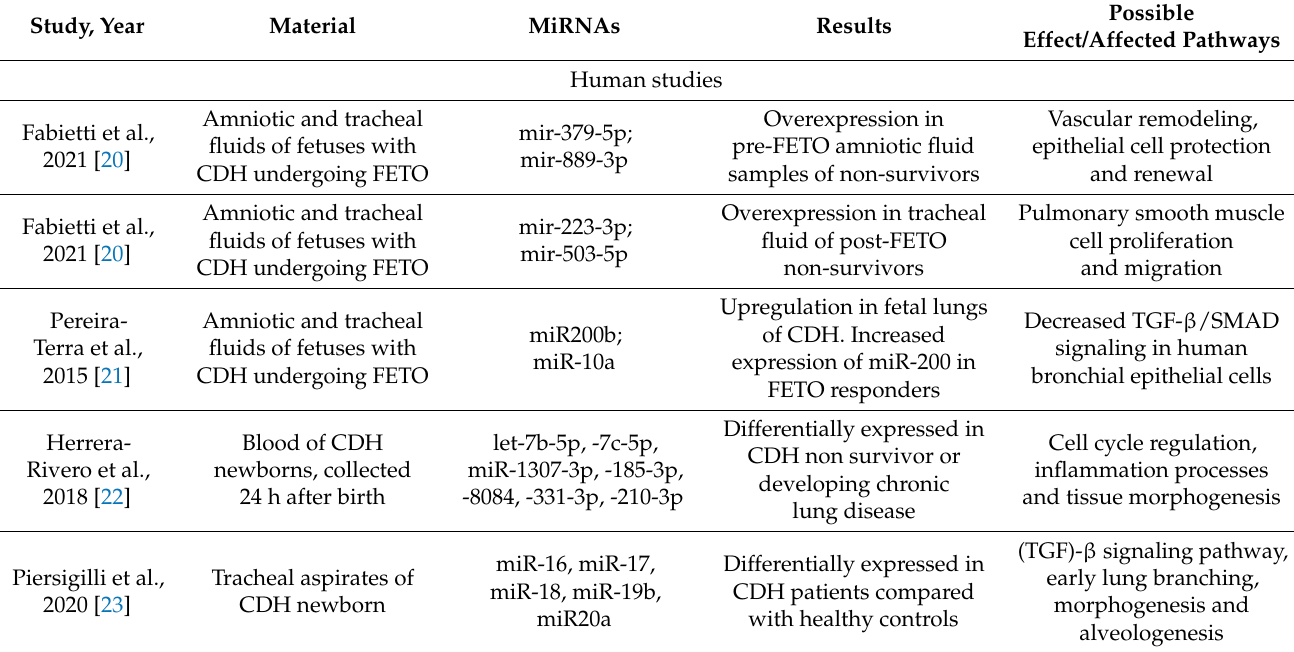
Table 2. Summary of current investigations on miRNA in CDH human